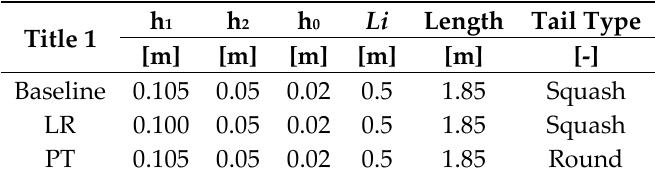
Table 1. Design parameters.